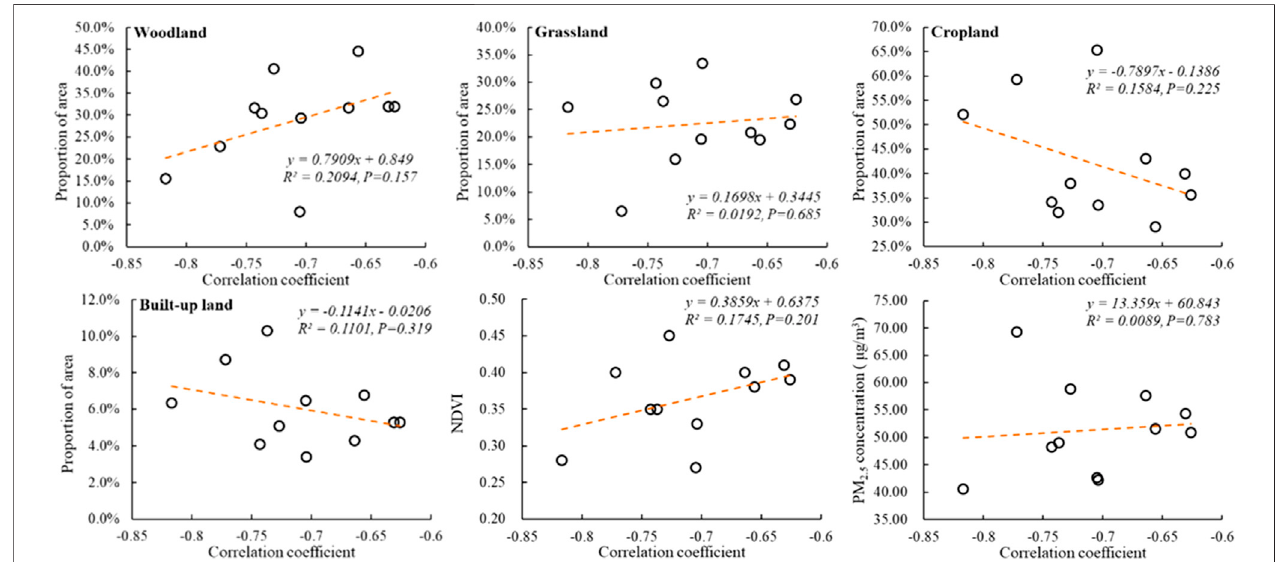
FIGURE 7 | The trends of the correlation coef fi cient between PM 2.5 concentration and NDVI with the change of NDVI, PM 2.5 concentration, and area of land cover types.